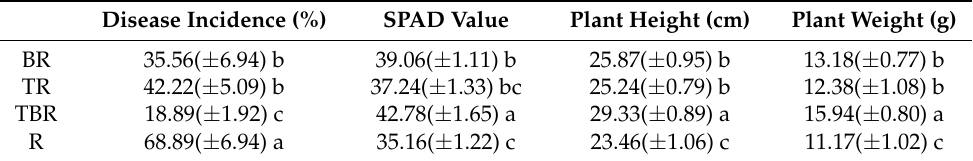
Table 1. Effect of Trichoderma virens and Bacillus velezensis on the plant height, plant weight, SPAD values, and disease incidence of